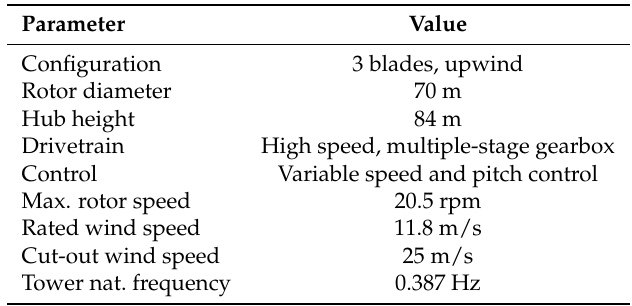
Table 13. The WindPACT 1.5-MW wind turbine